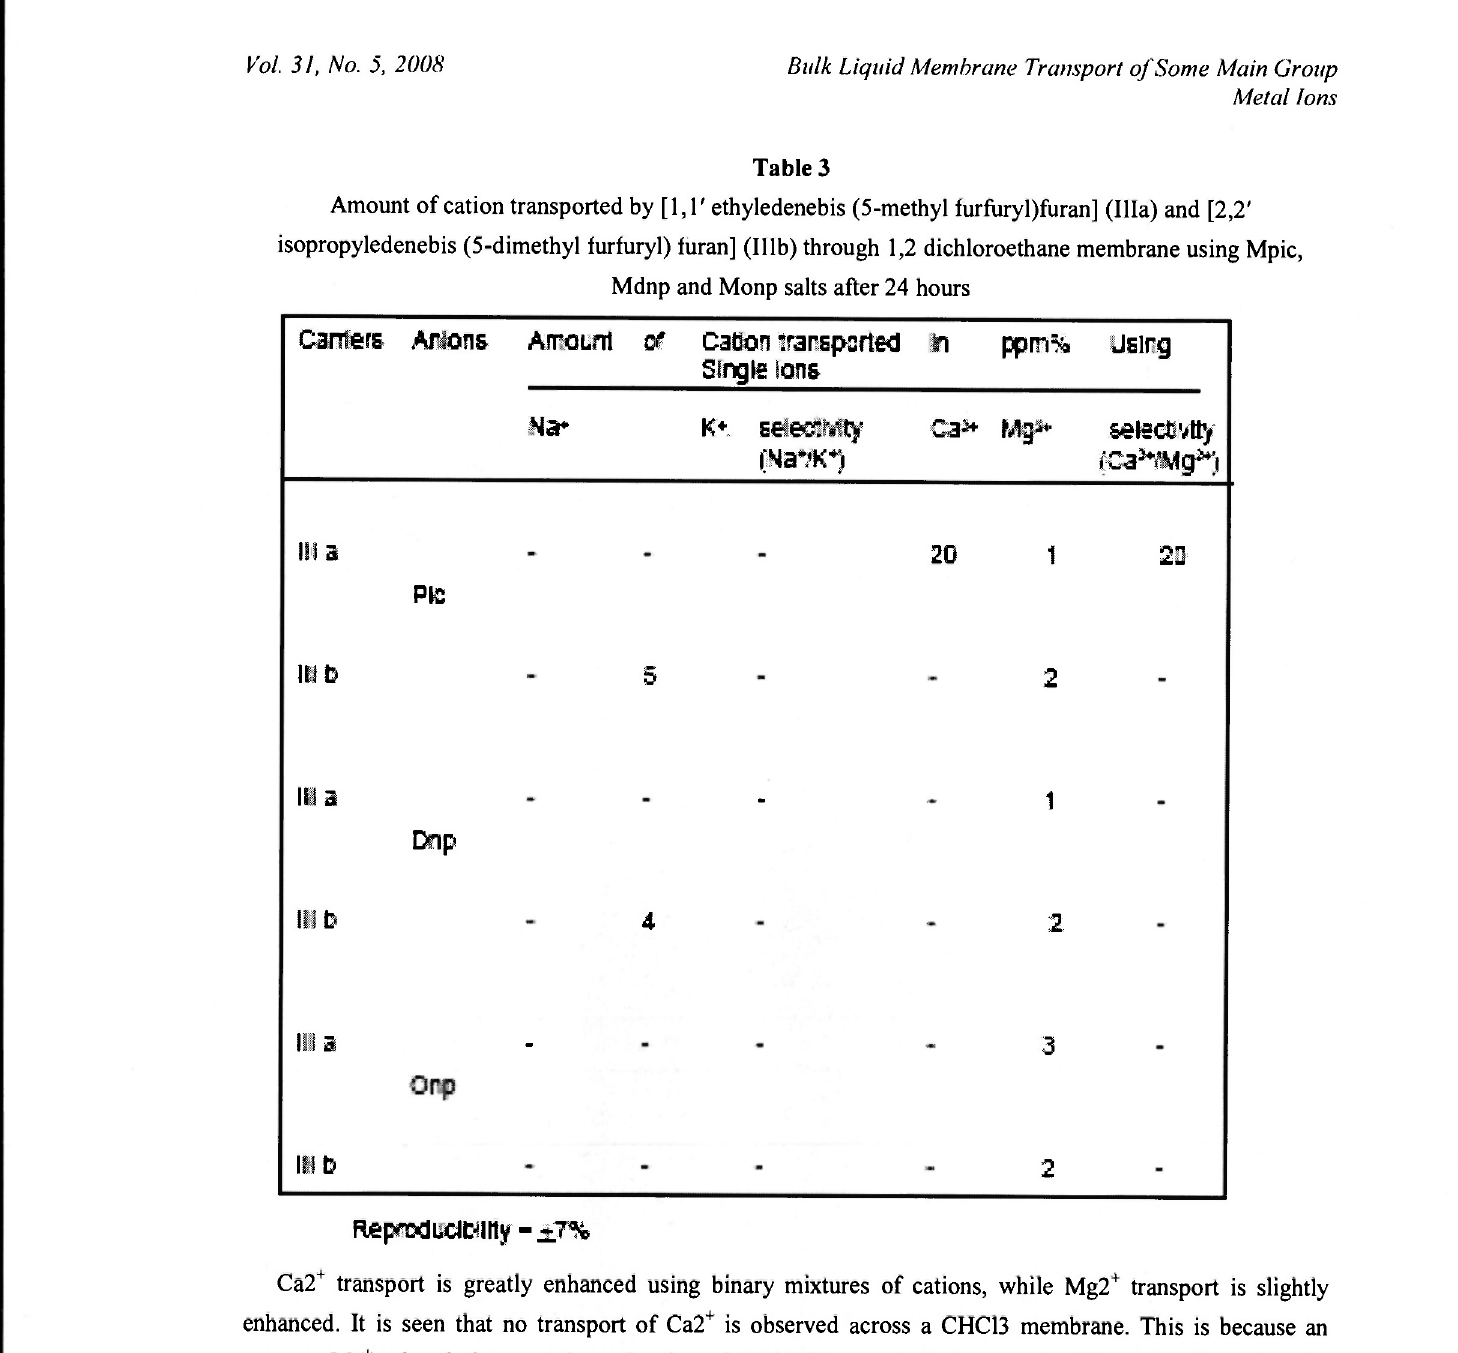
Amount of cation transported by [1,1' ethyledenebis (5-methyl furfiiryl)furan] (Ilia) and [2,2' isopropyledenebis (5-dimethyl furfuryl) furan] (Illb) through 1,2 dichloroethane membrane using